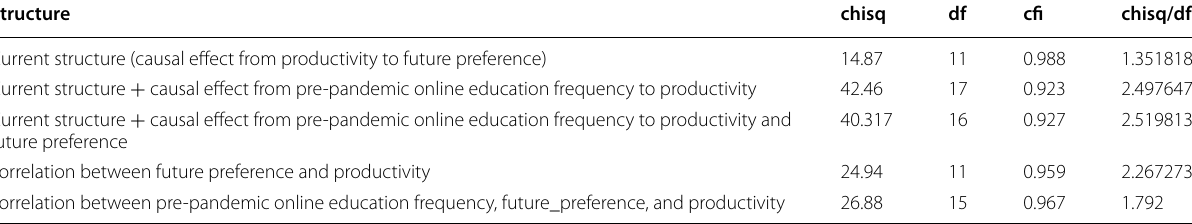
Table 3 Different combination of effects among potential endogenous variables